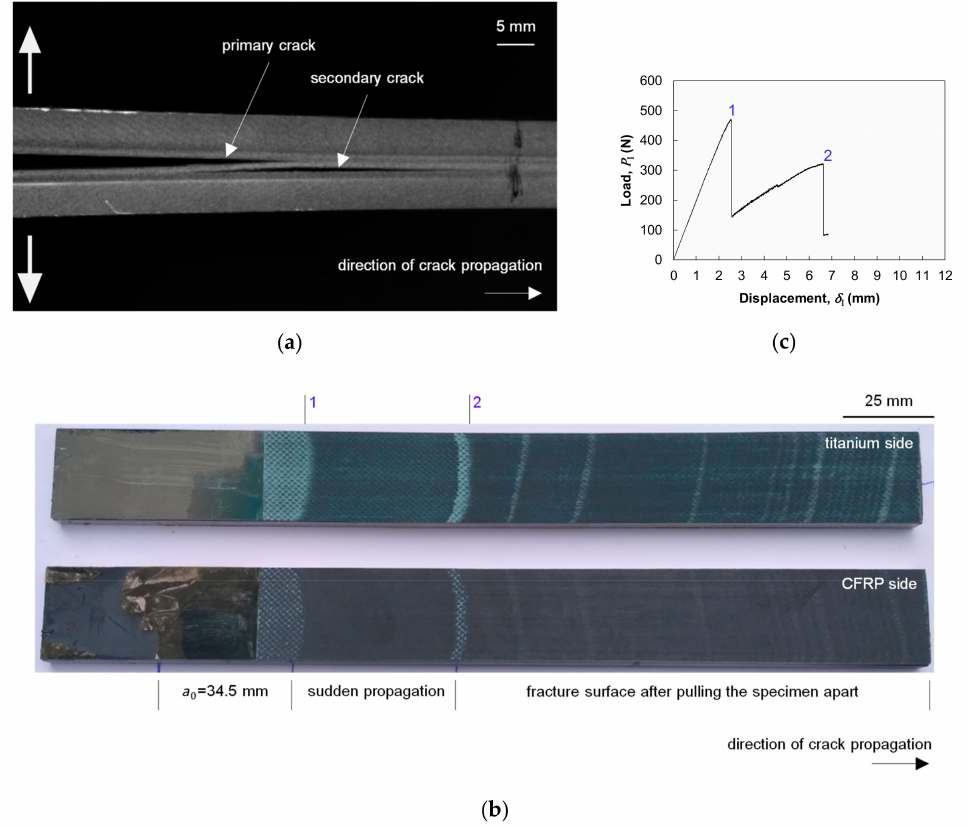
Figure 7. ( a ) A representative snapshot capturing the development of a secondary crack, interlaminar between the CFRP’s first and second layers, during the experimental testing of the specimens using manufacturing option (MO) 1. The MO 2 and 3 specimens exhibited the same behavior. ( b ) Fracture surfaces of a typical specimen from MO 4 and ( c ) their correlation with the respective load–displacement